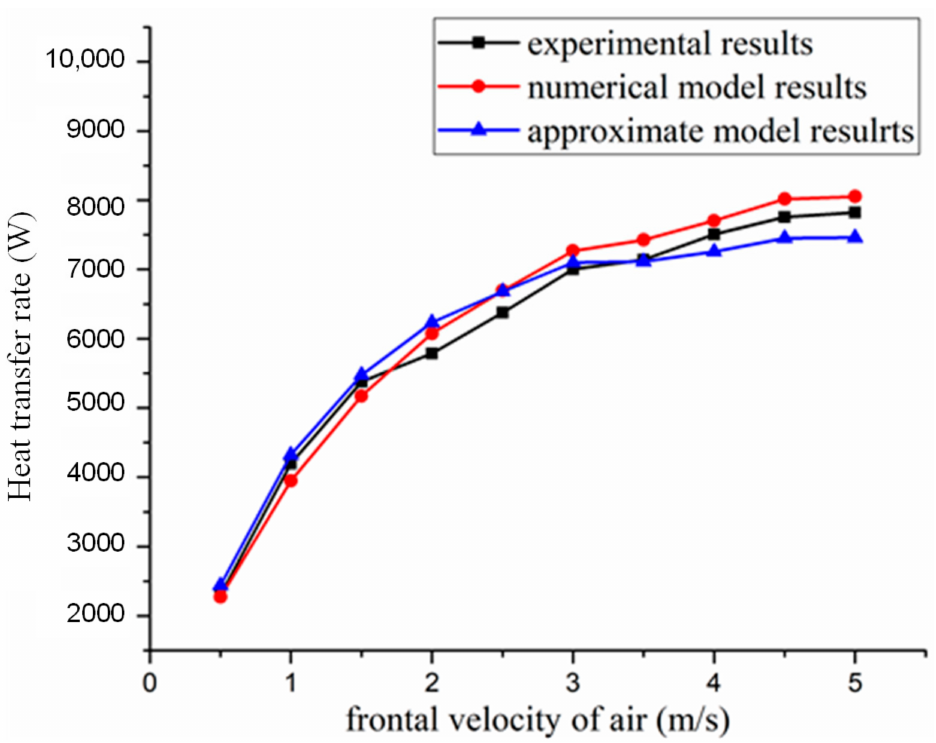
Figure 6. Comparison between experimental and calculating